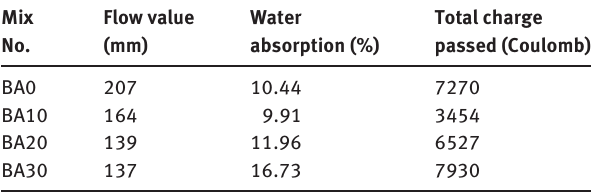
Table 4 Flow value, water absorption, and total charge passed of cement-based